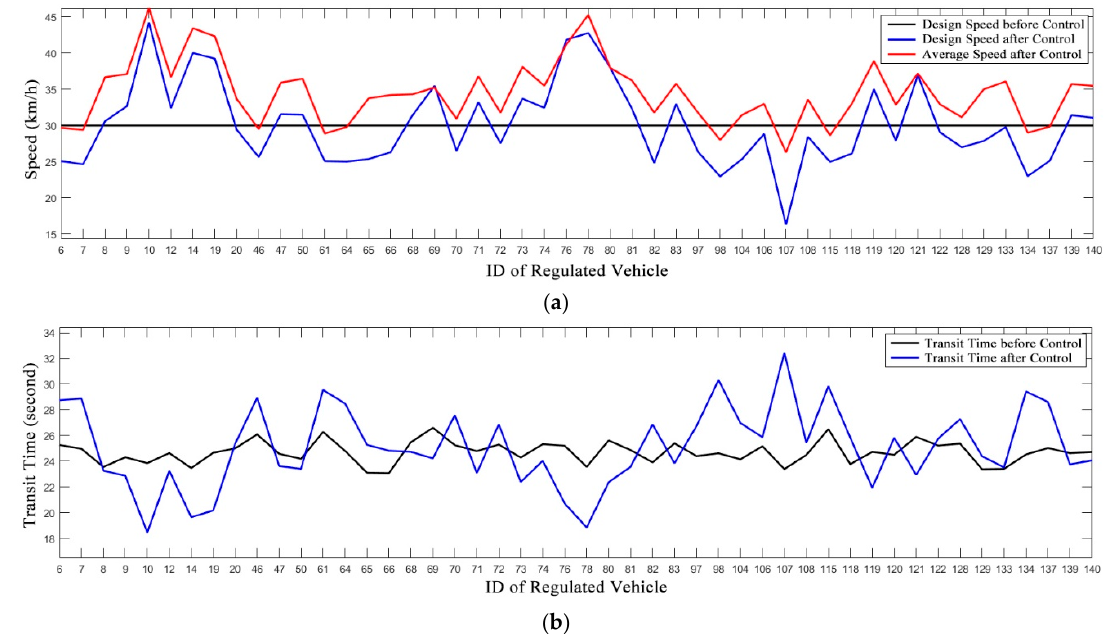
Figure 17. Impacts of conflict resolution on regulated vehicles in the 150A test scenario. ( a ) Vehicle speed before and after speed control; ( b ) transit time before and after speed control. Table 6. Motion information in multi-vehicle collisions.